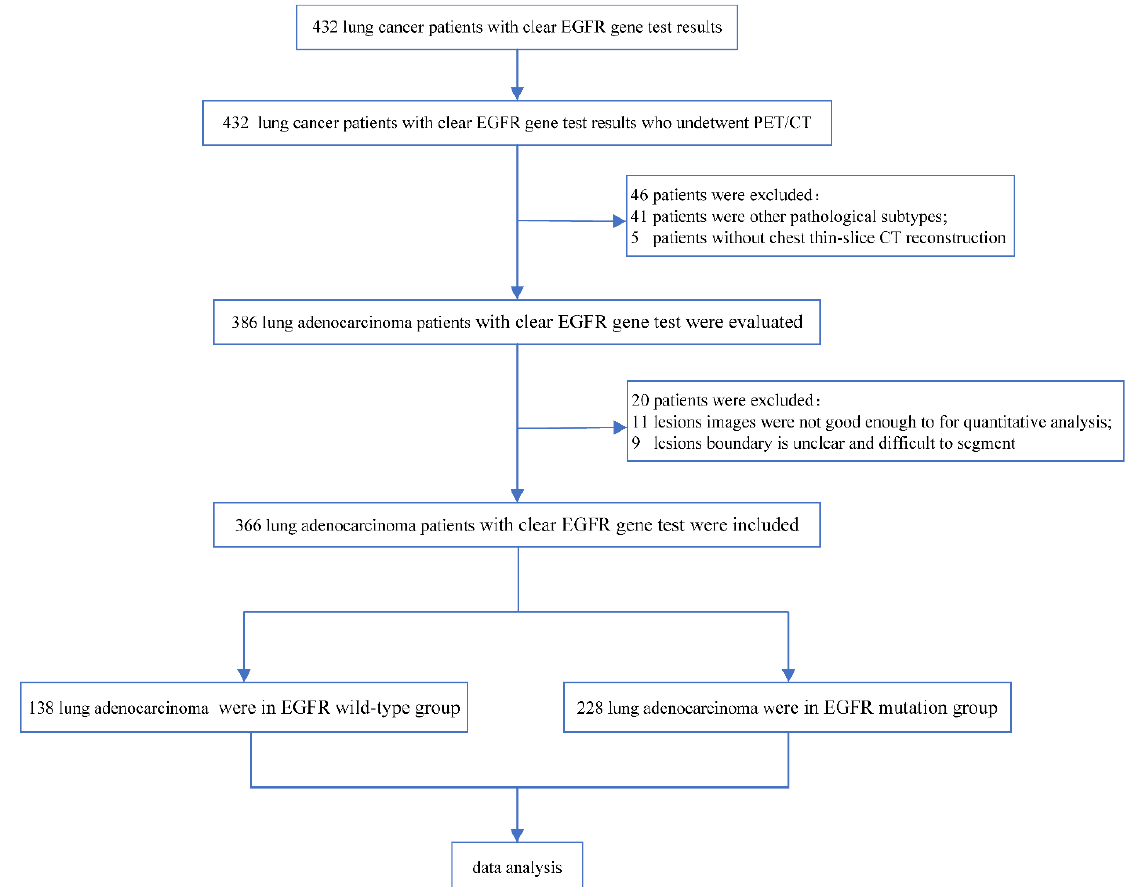
Figure 1. Flowchart of patient selection. EGFR, epidermal growth factor receptor.